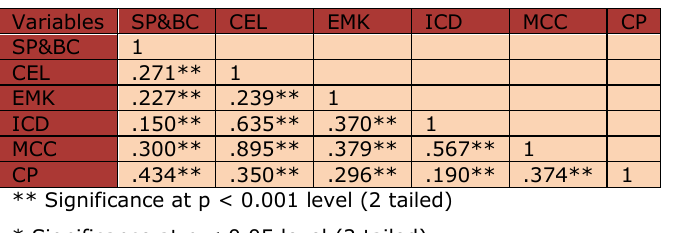
Table 1. Pearson correlation between knowledge management practices and company performance ( SP&BC: sharing of best practices & building of consistent process; CEL: Continues employee learning; EMK: Effective management of knowledge; ICD: Innovative culture development; MCC: Management of core competencies: CP: Company